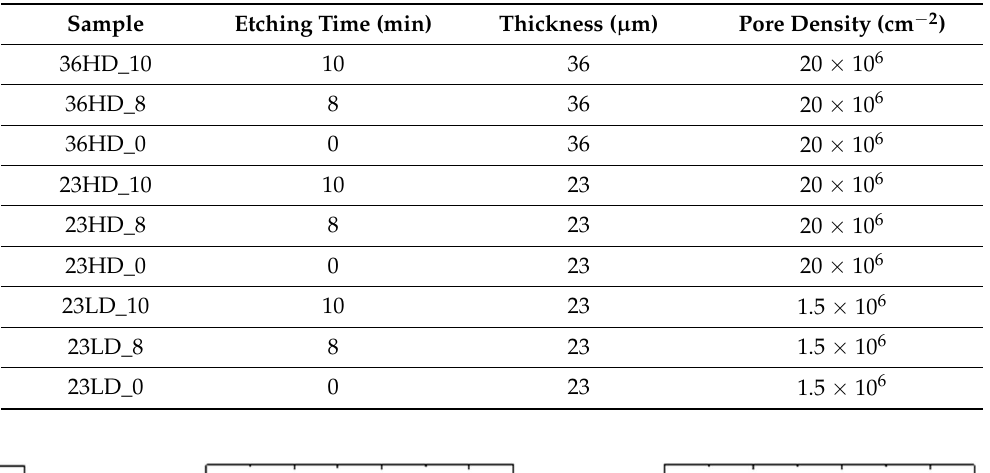
Table 1. Processing parameters of the three types of porous PET substrates etched for duration of 0 min (not etched), 8 min, and 10 min, together with sample coding: (i) thickness of 36 µ m with high pore density (HD), (ii) thickness of 23 µ m with high pore density (HD), and (iii) thickness of 23 µ m with low pore density (LD).